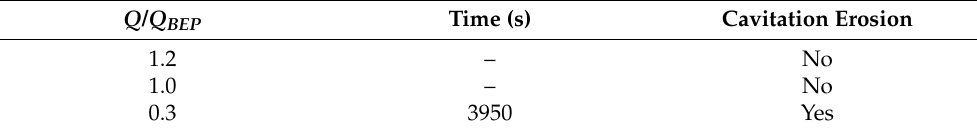
Table 2. Research results for the impeller № 2 with the rim ( n = 2000 rpm, NPSH = 3.65 m). Q / Q BEP Time